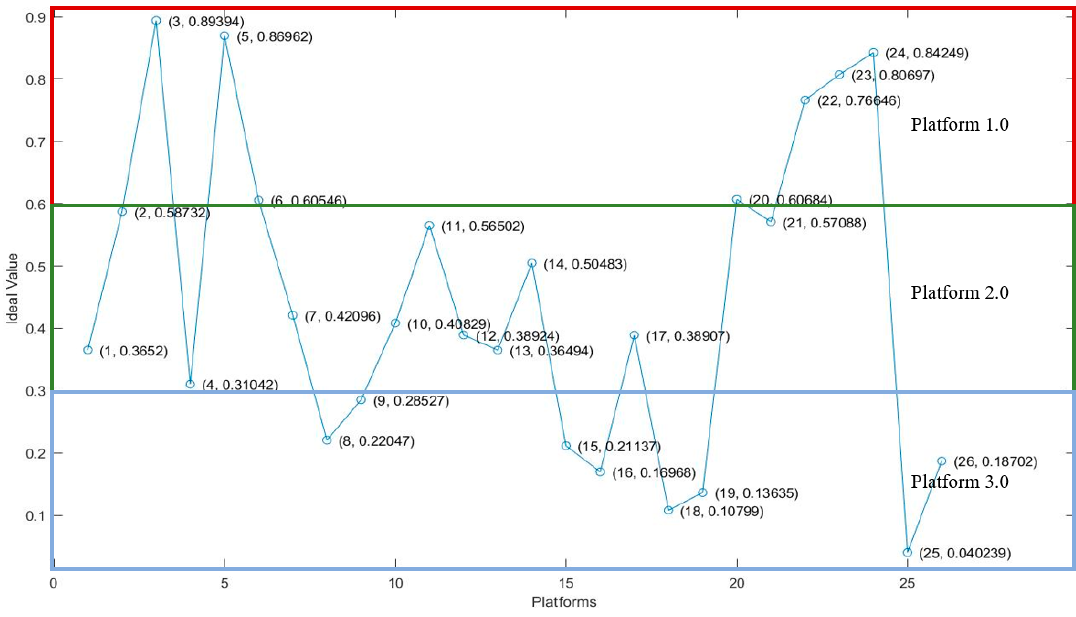
Figure 3. Development stage division of the construction industry Internet platform.